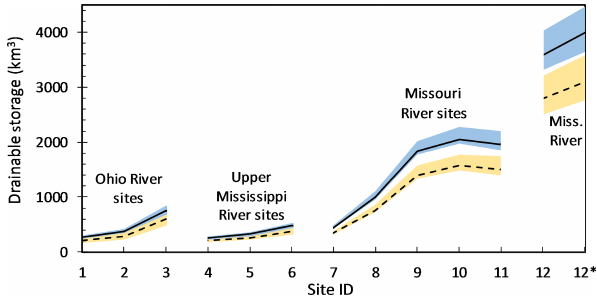
Figure 4. Estimated drainable basin storages ( S ) for non-winter months (April–October) during the period 2002–2014 based on storage offsets derived using a zero-flow condition of 0.1% and 0.01% of Q min ; shaded regions show corresponding measured stor- age ranges from GRACE; subbasin outlet locations are shown in Fig. 1; site ID 12 ∗ corresponds to estimated storage based on area- weighted values from the Ohio, upper Mississippi and Missouri River